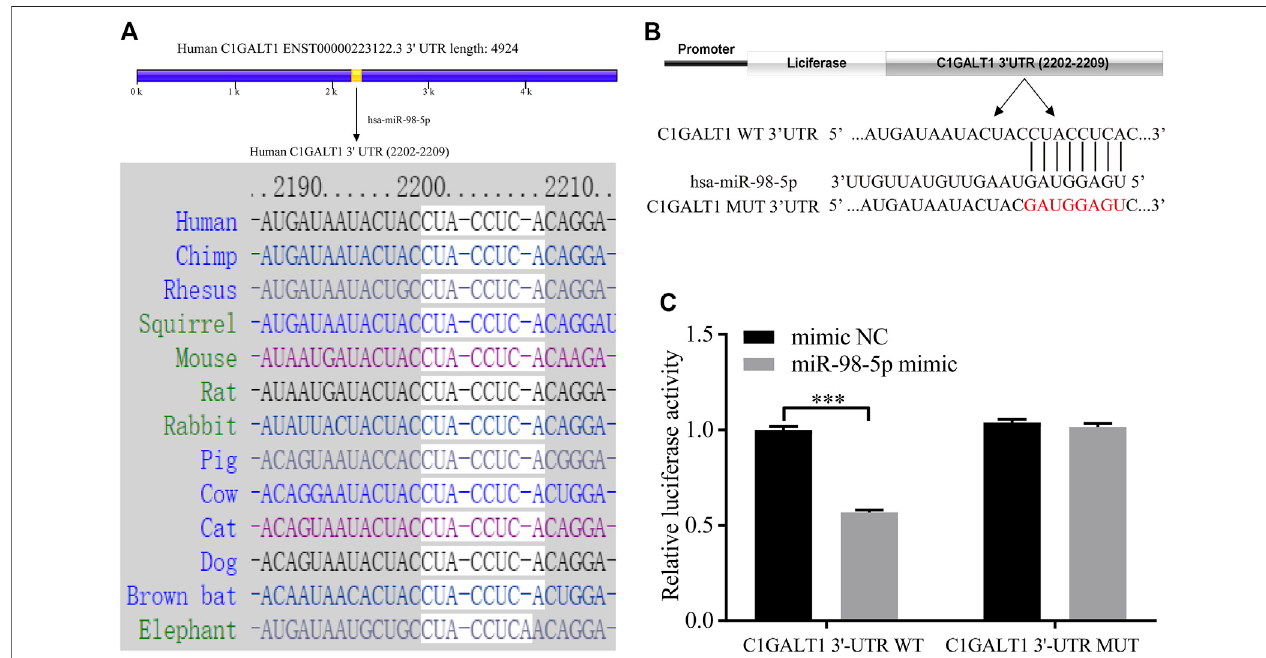
FIGURE 4 | C1GALT1 represents a potential target gene of miR-98-5p. (A) Schematic diagram depicting the prediction of C1GALT1 as a potential target gene of miR-98-5p, as determined by TargetScan. (B) Schematic view of the luciferase reporter vector. (C) Relative luciferase activity of the C1GALT1-3 ′ UTR WT or C1GALT1- 3 ’ UTR MUT reporter co-transfected with miR-98-5p mimic or mimic NC. The relative luciferase activity of C1GALT1-3 ’ UTR WT reporter in mimic NC and miR-98-5p were 1.00 ± 0.16 and 0.57 ± 0.01; the relative luciferase activity of C1GALT1-3 ’ UTR MUT reporter in mimic NC and miR-98-5p were 1.04 ± 0.15 and 1.02 ± 0.02. NC, negative control. *** p < 0.001. Note: C1GALT1, β -1, 3-galactosyltransferase; WT, wild type; MUT, mutant